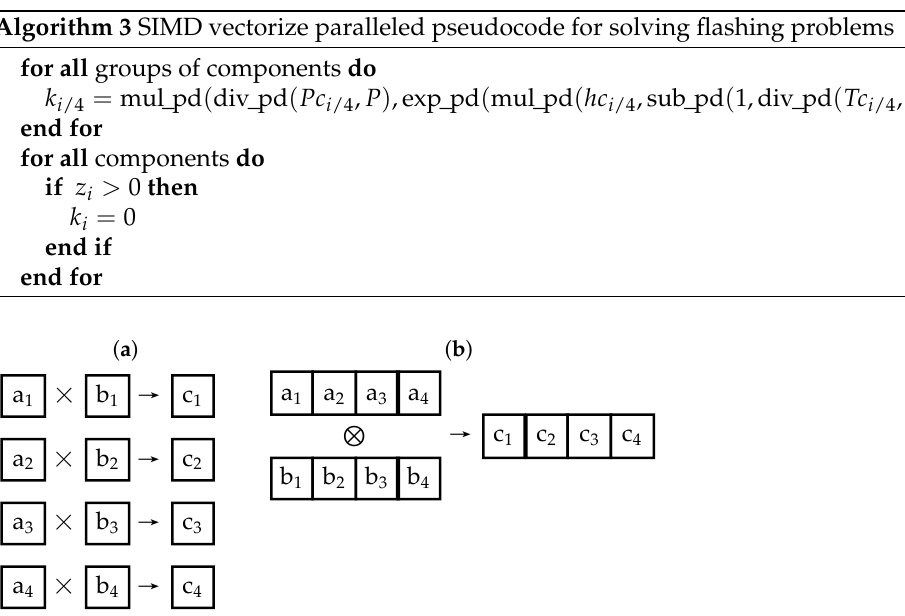
Algorithm 3 SIMD vectorize paralleled pseudocode for solving flashing problems